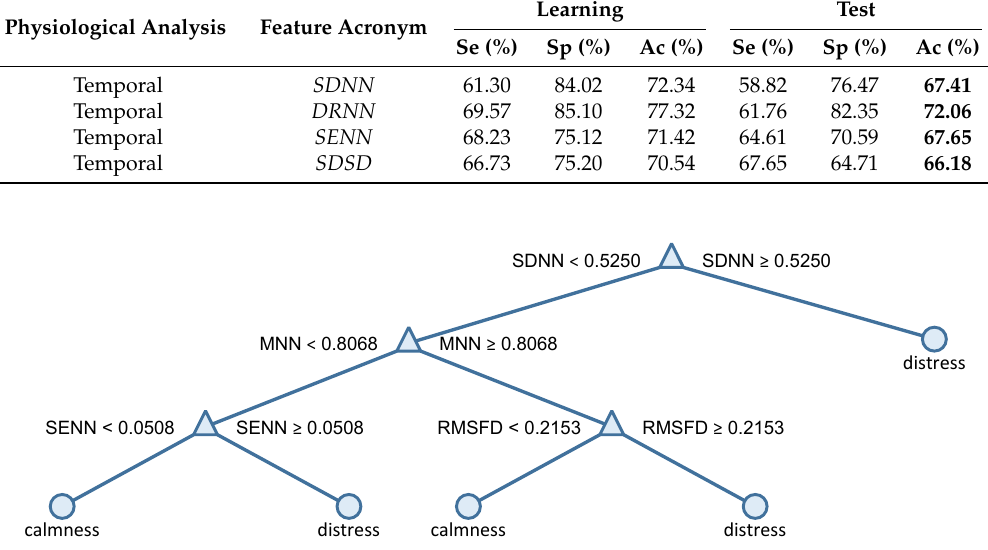
Figure 4. Tree-based discriminant models obtained by considering SDNN, MNN, SENN and RMSFD (the first derivative of root mean square) values from all PRV (pulse rate variability)